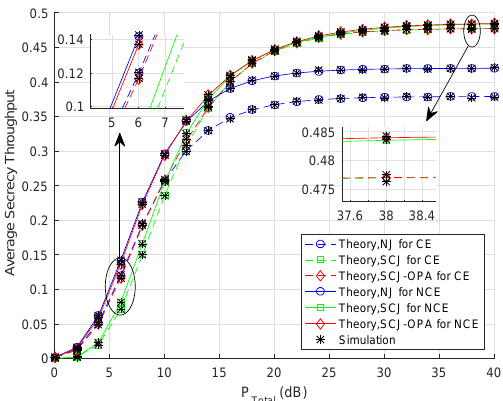
Figure 3. Average Secrecy throughput vs. the total transmit power budget P Total for the three proposed transmission schemes when R s = 1 (bit/s/Hz), M = L = 2, K = 2.